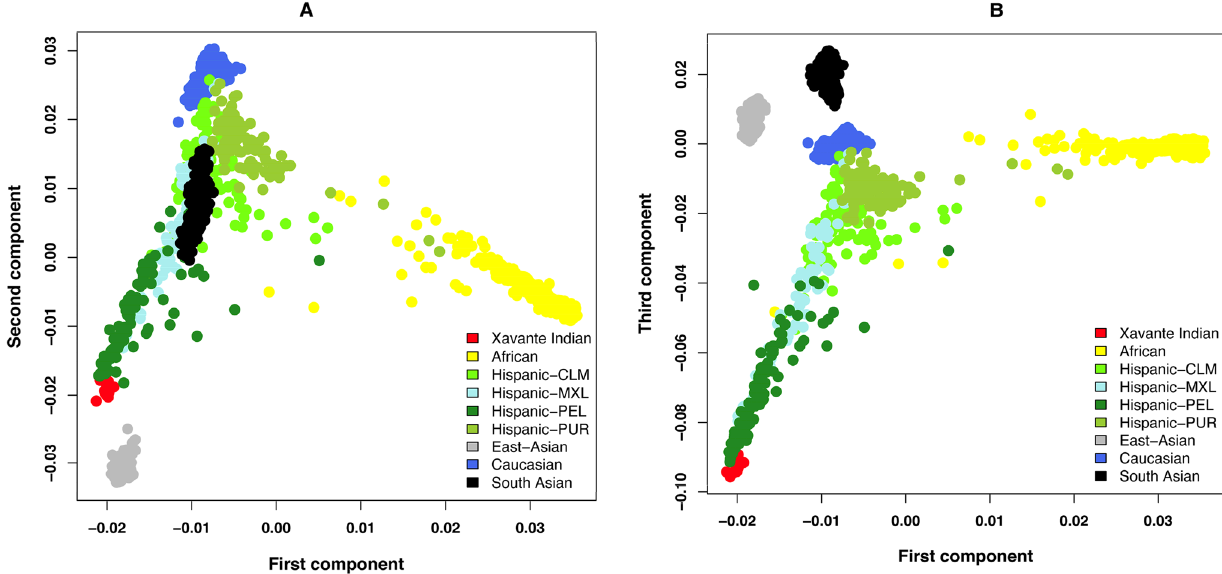
Figure 1. Princiapl Component Analysis (PCA) plots of the admixture analysis of the 14 Xavante Indian samples together with the 2548 normal samples from 1000 genome project. 291,984 SNPs shared among all populations were used. ( A ) PCA plot for components 1 and 2. ( B ) PCA plot for components 1 and 3. This confirms that the populations were well matched with respect to genetic background and Xavante Indian is a unique genetic